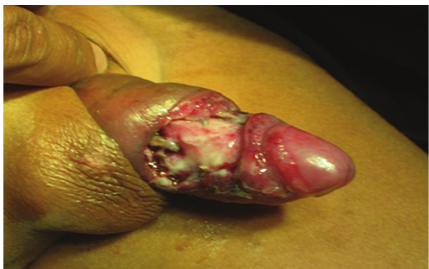
Figure 1: During examination of the penile shaft, several maggots were seen crawling out from underneath the skin.